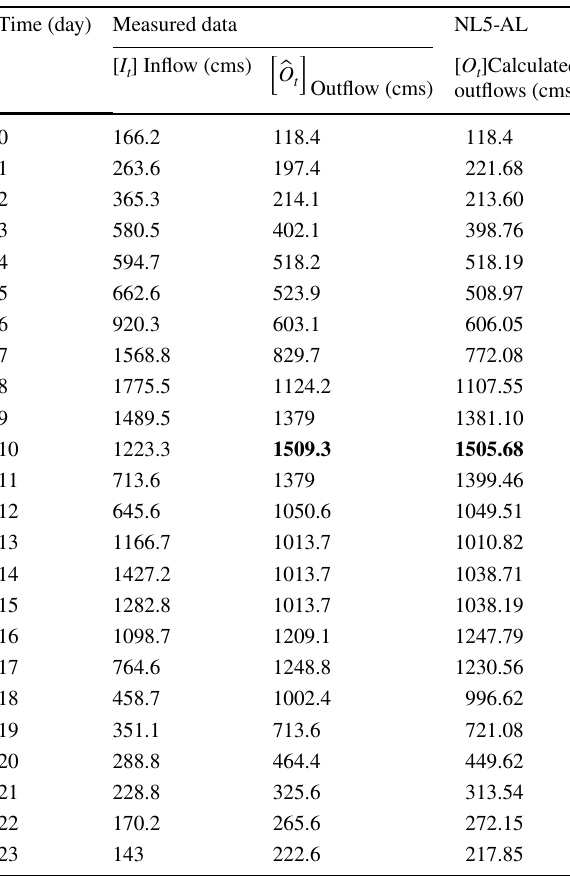
Table 3 Results related to the third example (Viessman and Lewis data) Time (day) Measured data